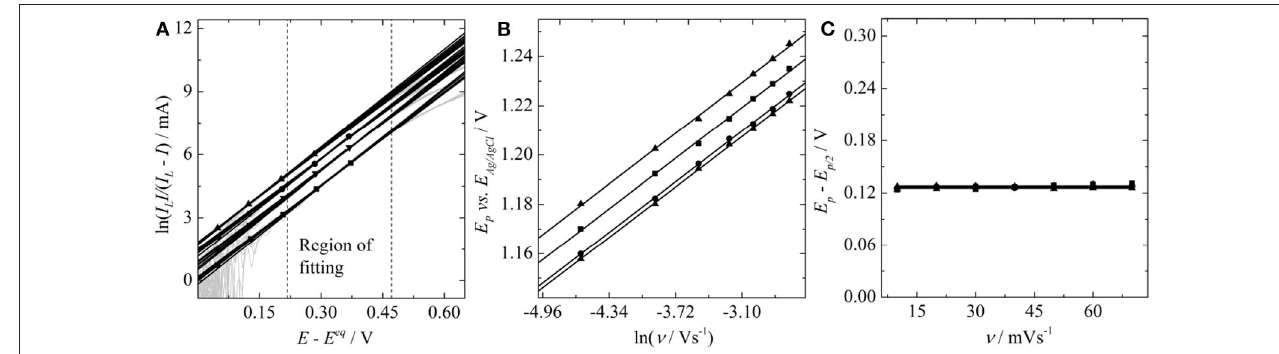
FIGURE 3 | (A) Tafel plots (dashed lines are the limits of the fitting region), (B) plot of the peak position vs. the logarithm of the scan rate, and (C) peak-shape analysis for the oxidation of vanadyl sulfate in concentrations of 0.02 M (square), 0.04 M (down-triangle), 0.06 M (circle), and 0.08 M (up-triangle) at a glassy carbon electrode in 2 M H 2 SO 4 .